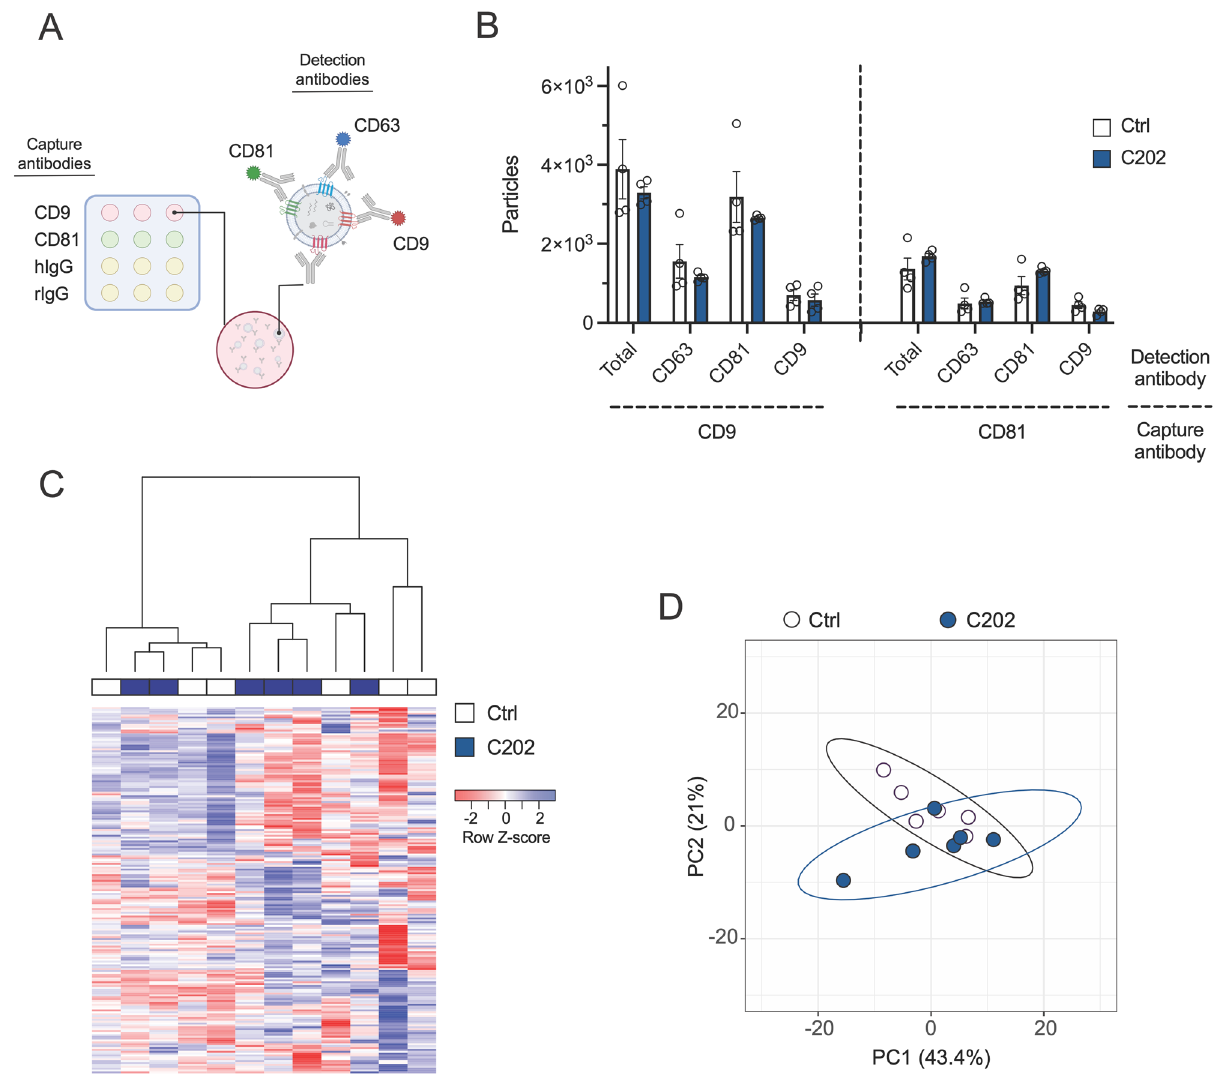
Figure 3. CD63-HA expression does not alter the tetraspanin composition or miRNA cargo of secreted extracellular vesicles (EVs). ( A ) Diagram of ExoView single particle interferometric reflectance imaging sensor technology (SP-IRIS) for the analysis of EV tetraspanin composition. An EV sample was applied to a silicon chip printed with an array of spots coated with capture antibodies raised against mouse tetraspanin EV protein markers (CD81 and CD9) and negative isotype controls (hamster and rat IgG). Captured EVs were then labeled with fluorescent antibodies directed against the mouse tetraspanins (CD9-AF488, CD81-AF555, and CD63-AF647). Spots with captured and labeled particles were imaged by interferometric reflectance for size and count, and fluorescent imaging to detect antibody labeling of individual EVs ( B ) ExoView SP-IRIS analysis of EVs isolated from control (Ctrl) and CD63-HA positive (C202) DC2 epididymal epithelial conditioned media identified no differences in the number of total, CD63-, CD81-, or CD9-positive EVs captured by spots printed with antibodies for CD9 or CD81. N = 4 samples isolated from conditioned media collected from distinct cell cultures. Particle counts were averaged across 3 identical spots on each chip/sample and displayed as mean ± SEM. Group means were assessed by student’s t-test, α = 0.05. ( C ) Heatmap visualization of miRNA expression of 195 total miRNA across EV samples demonstrated the lack of overall differences in the pattern of miRNA expression between Ctrl or C202 EVs. Hierarchical clustering of samples by Spearman correlation segregated these samples into 2 large non-exclusive clades. miRNA were clustered by pairwise Pearson. N = 6 samples isolated from conditioned media. ( D ) A principal component analysis (PCA) clustering of EV miRNA samples that is unable to distinguish between samples isolated from Ctrl or C202 cell lines. The majority of samples from each cell line (4 of 6) were contained within a region of overlap between 95% confidence ellipses for each